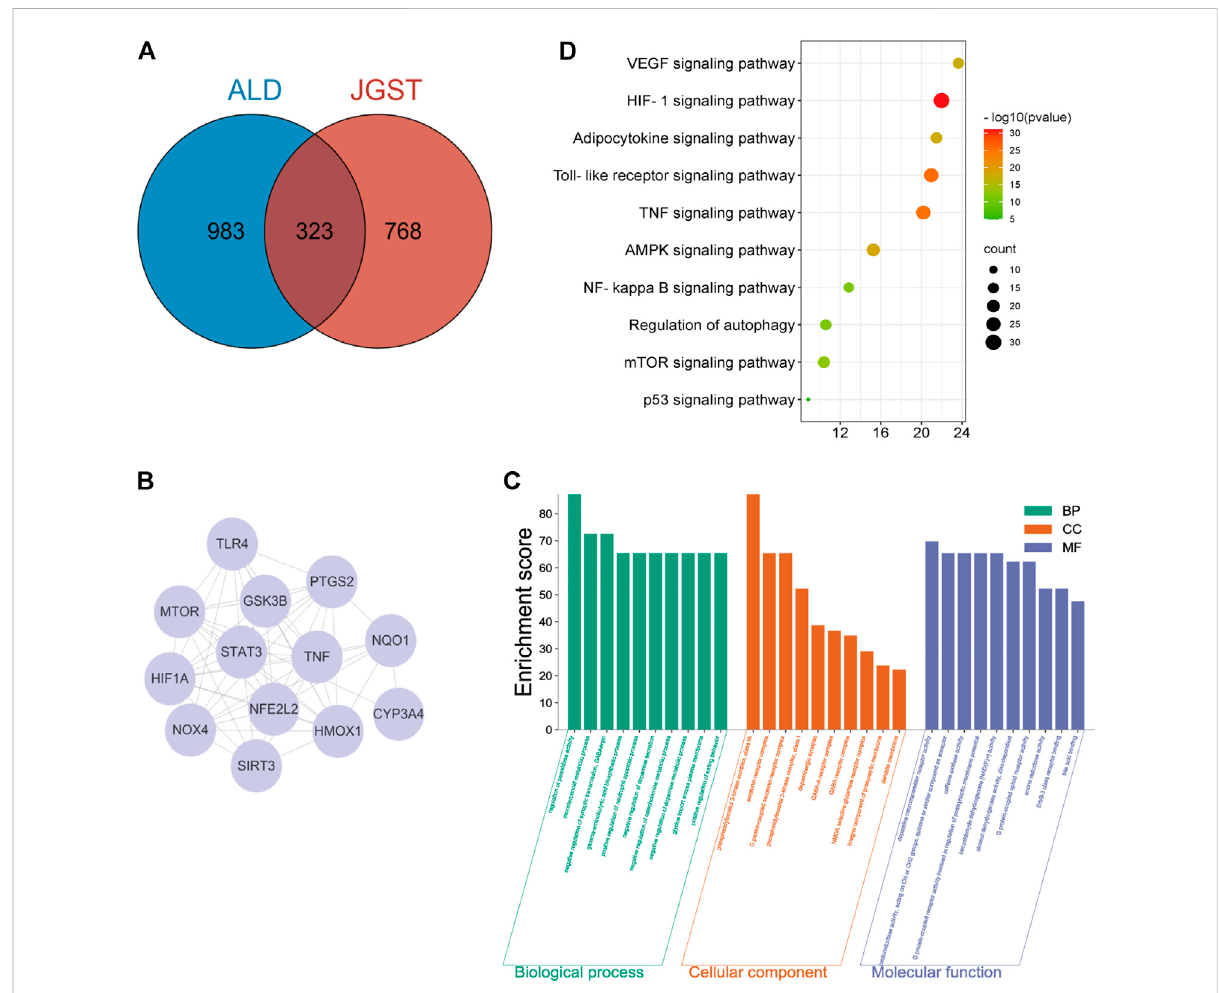
FIGURE 2 JGST on Chronic Alcoholic Liver Injury by network Pharmacology (A) JGST-Chronic ALcoholic Liver Injury Intersection Target Venn Diagram. (B) PPI network diagram of the core target. (C) GO enrichment analysisof Overlapping target. (D) KEGG Pathway enrichment analysis of overlapping